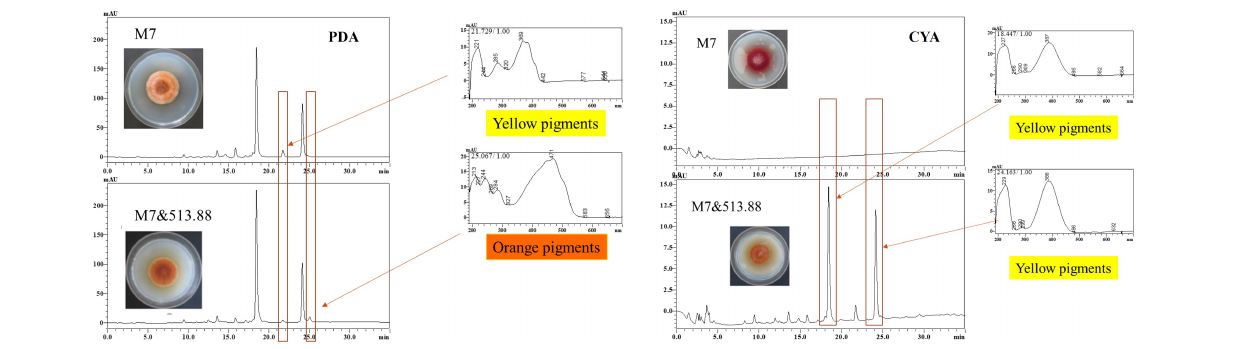
FIGURE 8 | High performance liquid chromatography results of MPs of monocultured Monascus ruber M7 and co-cultured M. ruber M7 with Aspergillus niger CBS